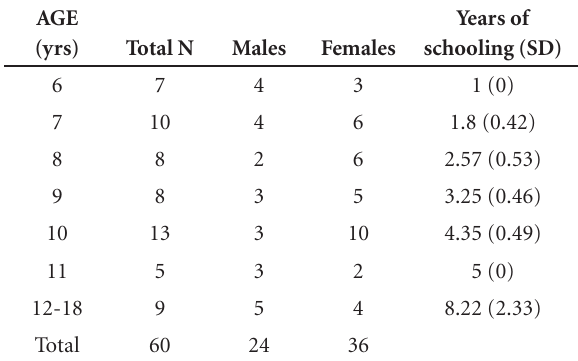
Table 1. Demographic features of children and adolescents in- cluded in the